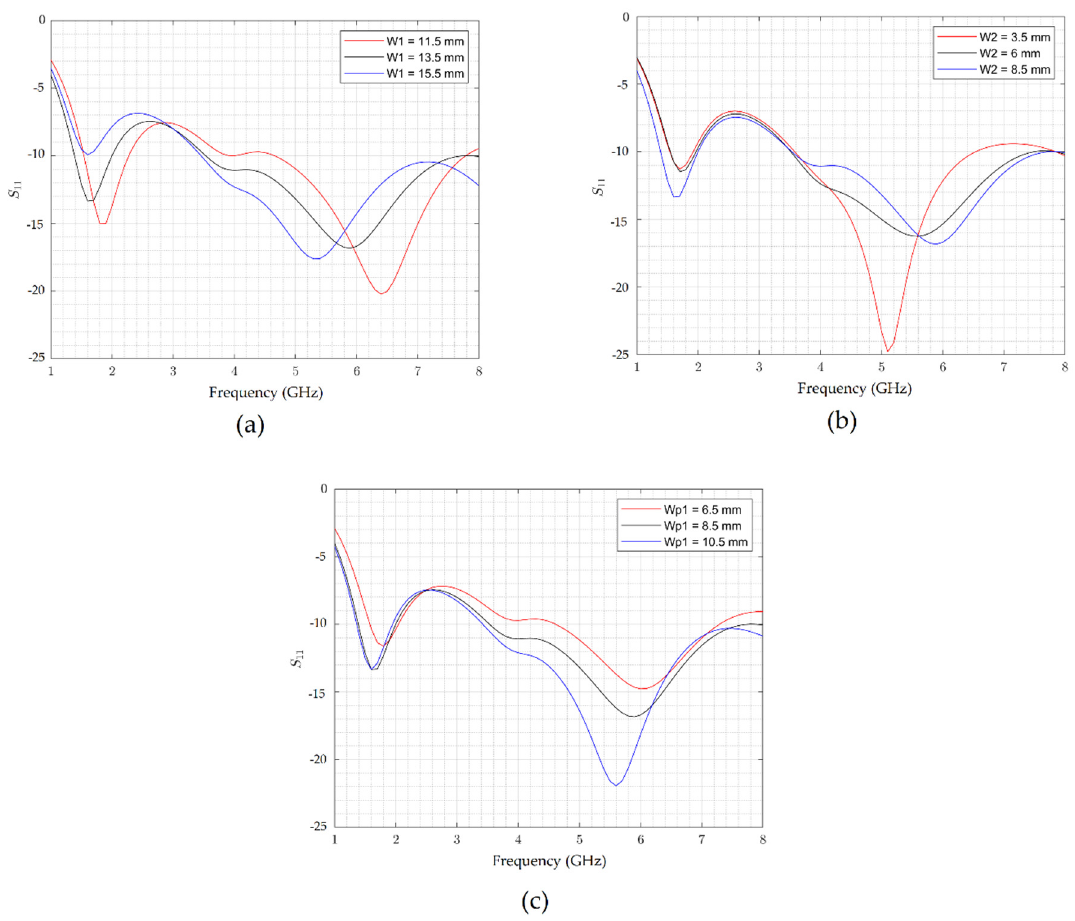
Figure 3. Simulated reflection coefficient of the ITO antenna for three parameters variations: ( a ) W1; ( b ) W2; ( c ) Wp1.